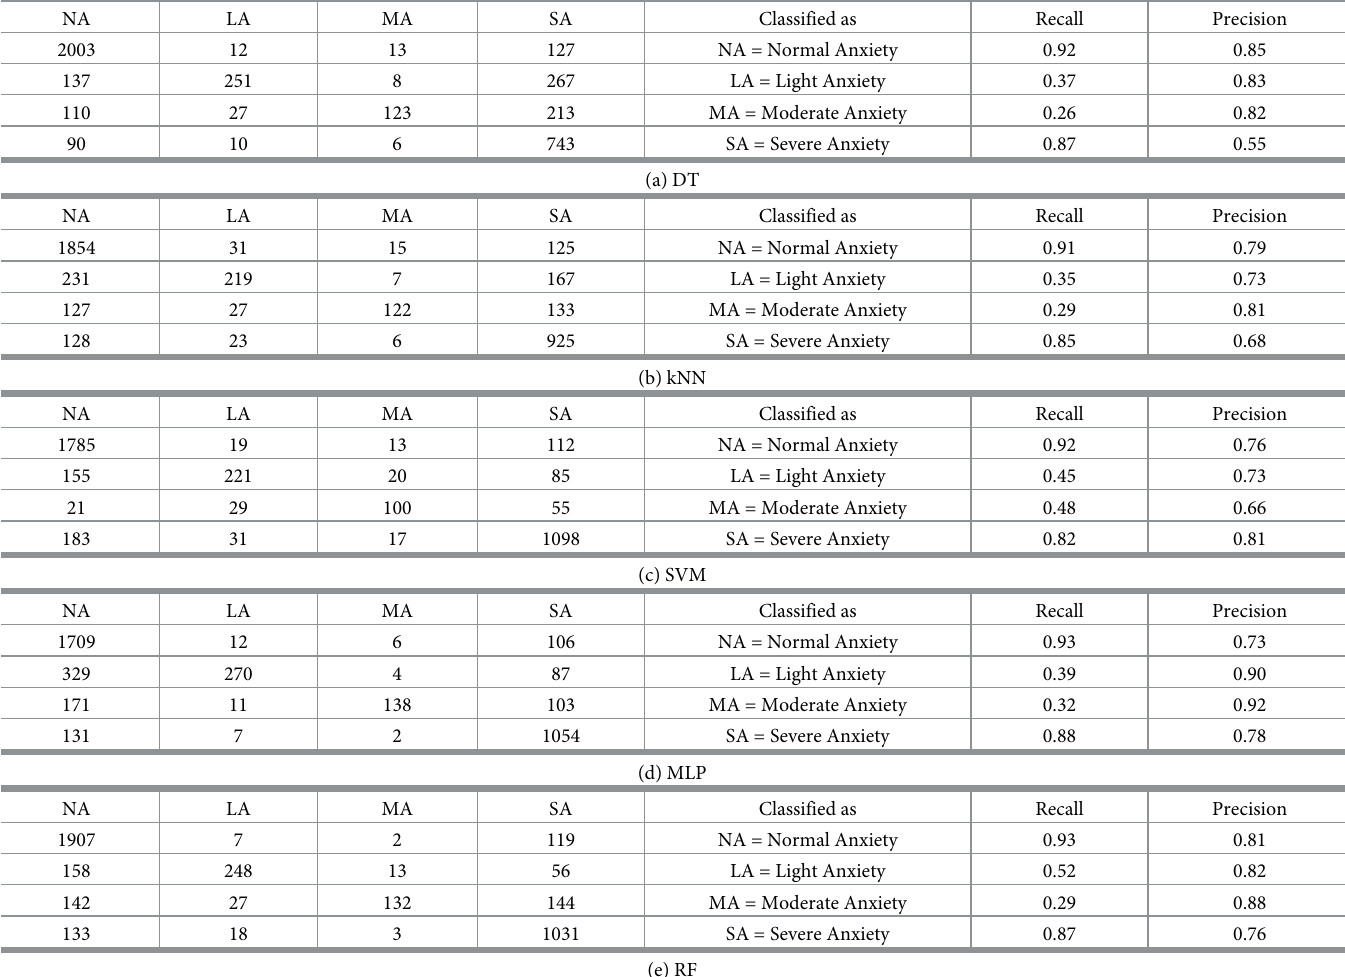
Table 4. Confusion matrix for four level anxiety classification for DT, k-NN, SVM, MLP and RF classifier using SAM based